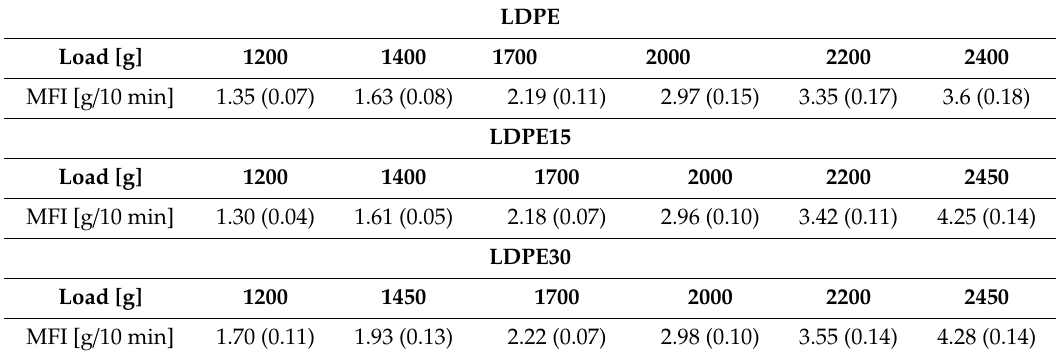
Table 3. Mold flow index ( MFI) results for the neat LDPE and for the obtained composites.